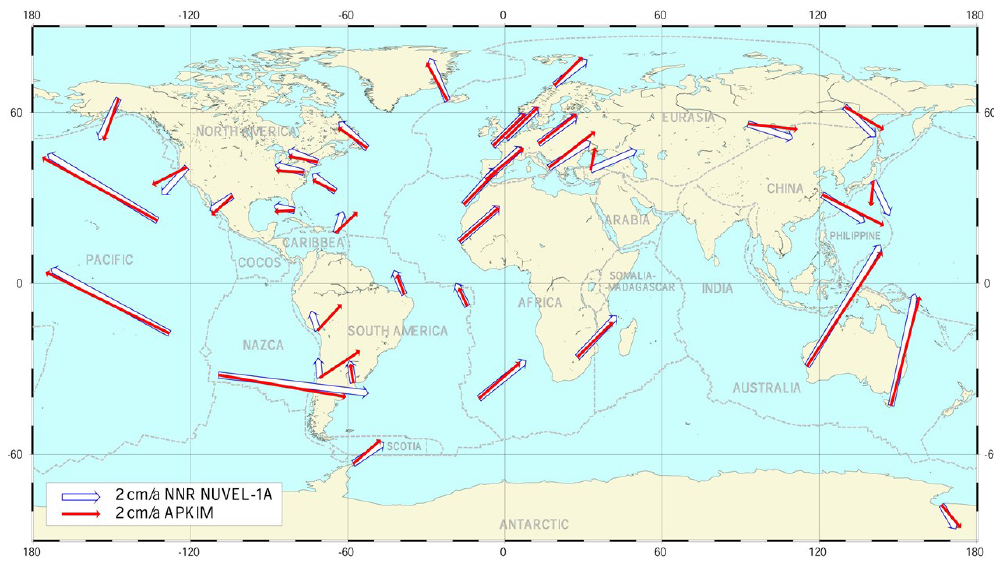
Figure 6. Comparison of actual plate kinematic models (APKIMs) from geodetic observations with a geophysical plate motion model (NNR-NUVEL-1A) derived from observations over millions of years (Drewes,